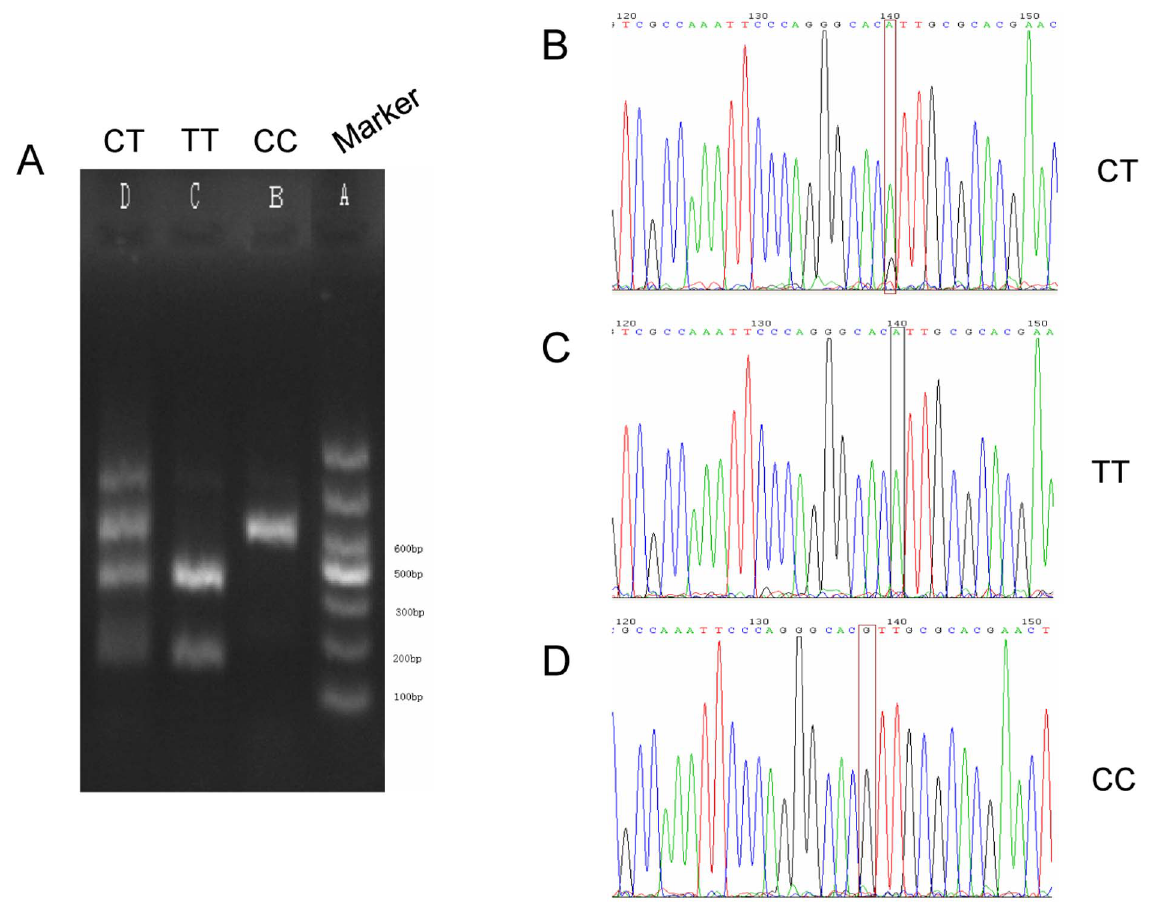
Figure 3. Genotype analysis for ERCC1 SNP C118T. A) Post-digestion PCR of alleles CT, TT, and CC (left to right). B) Heterozygous sequence analysis of CT genotype. C) Sequence analysis of TT genotype. D) Sequence analysis of CC genotype.